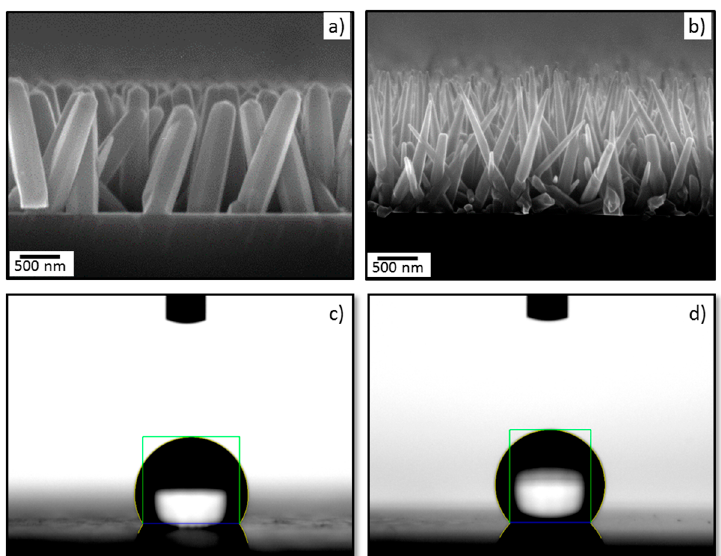
Figure 2. Cross-sectional SEM imaging of the ZnO rods ( a ) and needles ( b ), and their corresponding surface wetting behavior (contact angle of water droplets on the rods ( c ) and needles ( d )).